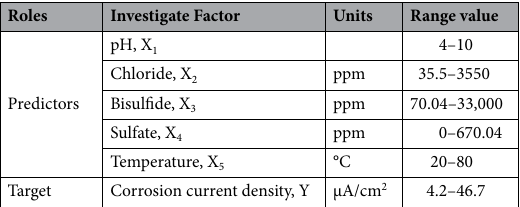
Table 1. Defined predictors and targets to predict the corrosion rate of carbon steel in